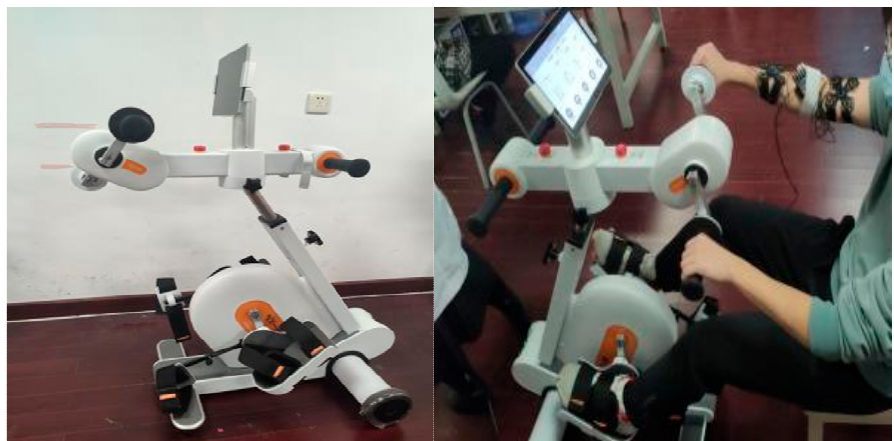
Figure 3. Bicycle ergometer for interlimb coordinated intervention.